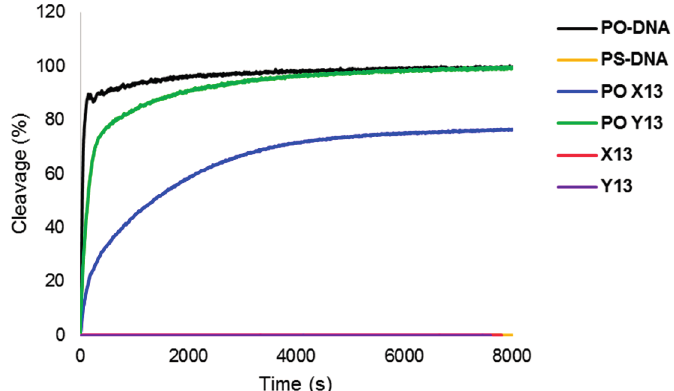
Figure 4. 3 ′ -Exonuclease degradation of individual Invader and reference